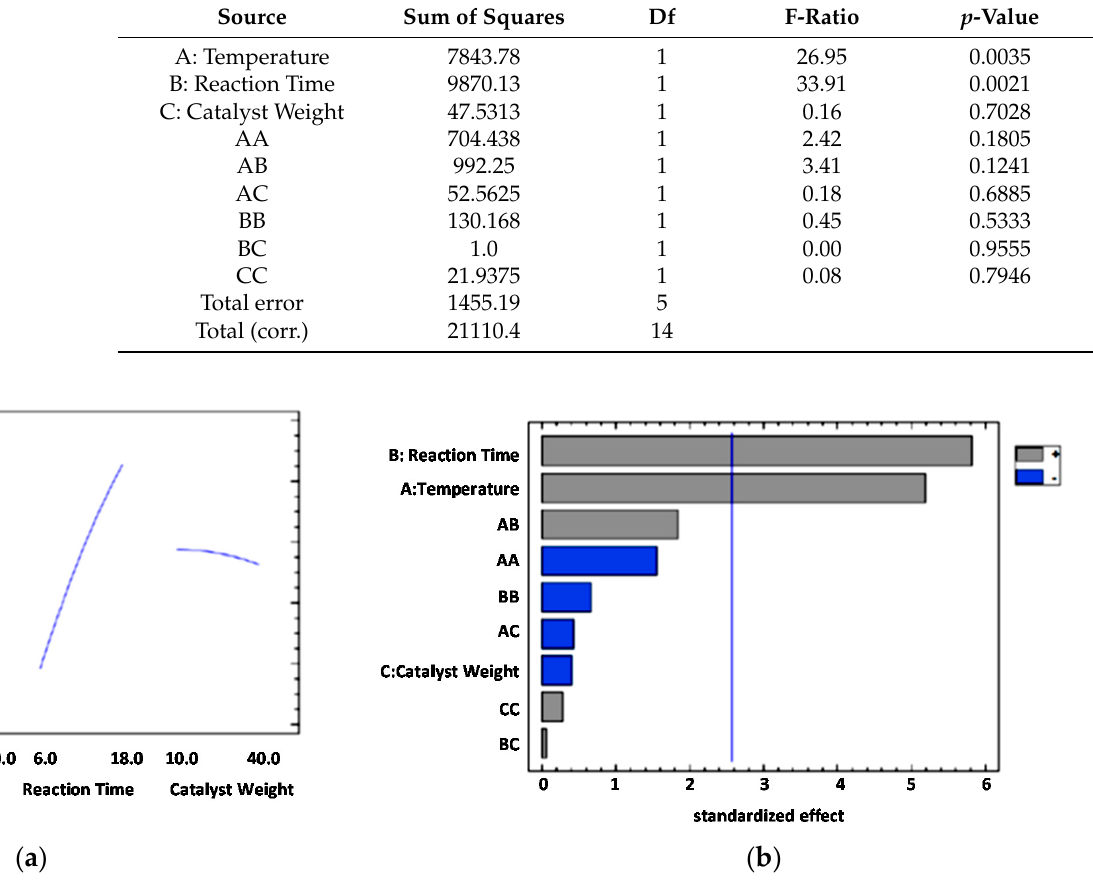
Table 3. Analysis of variance for reaction yields.